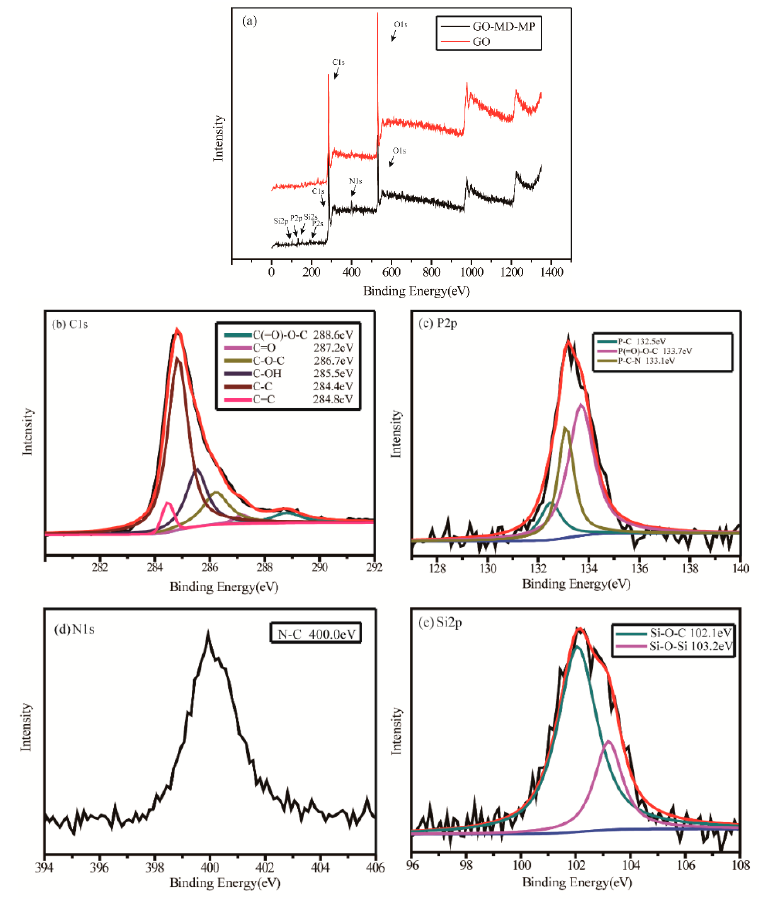
Figure 4. X-ray photoelectron spectroscopy (XPS) survey spectra of GO-MD-MP ( a ), C1s spectrum of GO-MD-MP ( b ), P2p spectrum of GO-MD-MP ( c ), N1s spectrum of GO-MD-MP ( d ), and Si2p spectrum of GO-MD-MP ( e ).